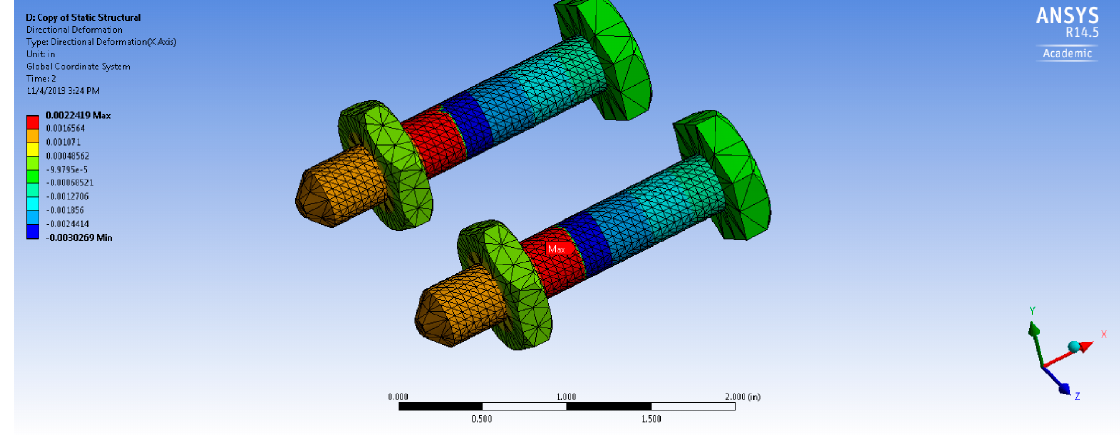
Figure 9. The joint’s lateral displacement as a reaction force function.